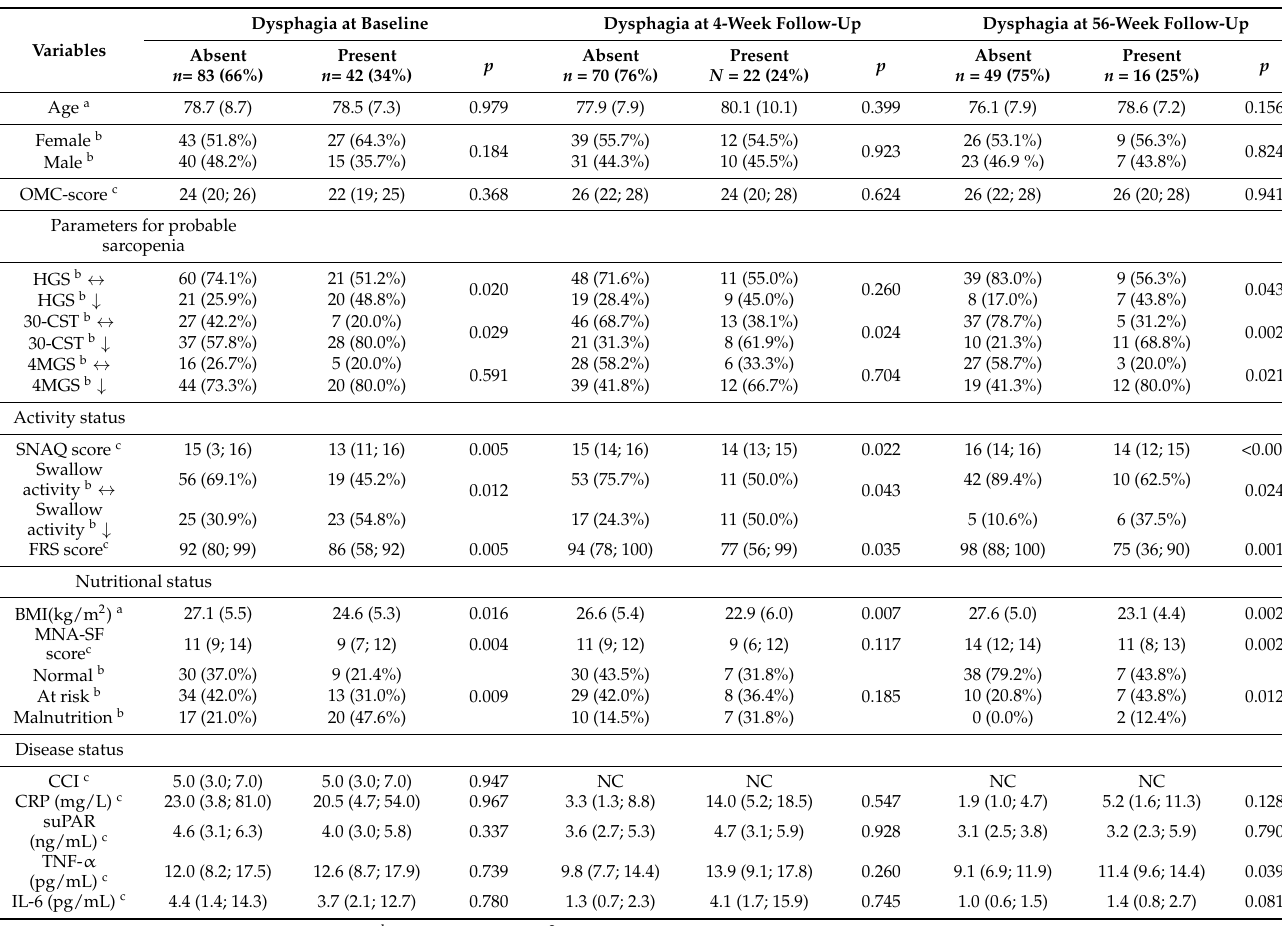
Table 2. Demographics, parameters for sarcopenia, activity, nutritional, and disease status according to signs of dysphagia by an EAT-score ≥ 2 points at three